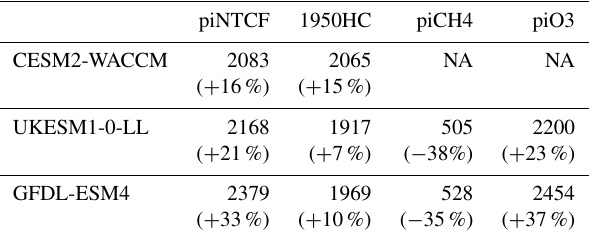
Table 4. Equilibrium PD global mean methane mole fractions (ppbv) inferred from PD methane lifetimes from the sensitivity ex- periments. Also shown are percentage changes compared to the ob- served PD value (1794ppbv) or, for the piCH4 case, the observed PI value